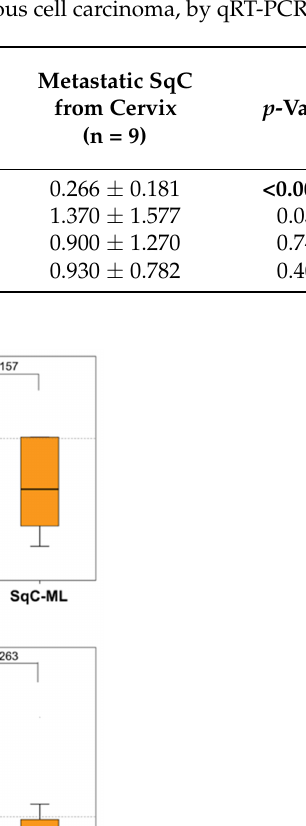
Table 2. The relative expression level of the four miRNAs in cervical squamous cell carcinoma compared with normal squamous epithelium, and in each group of cervical squamous cell carcinoma without metastasis, with metastasis, and metastatic squamous cell carcinoma, by qRT-PCR.